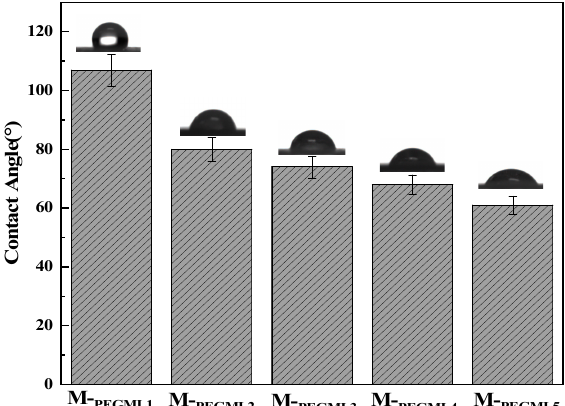
Figure 6. Contact angle of PTFE microfiltration membrane surface after pre-wetting with different concentrations of PEGML.